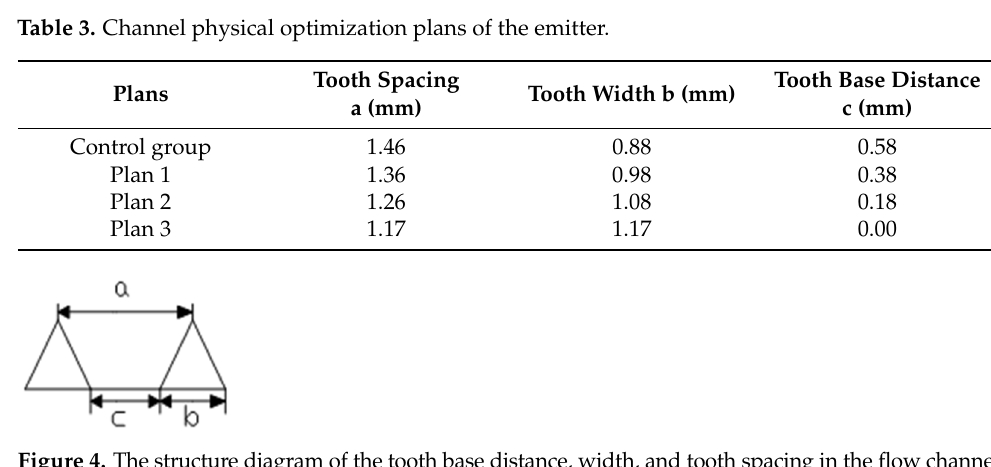
Figure 4. The structure diagram of the tooth base distance, width, and tooth spacing in the flow channel of the emitter. The letter a is the tooth spacing, b is tooth width and c is tooth base distance, mm.